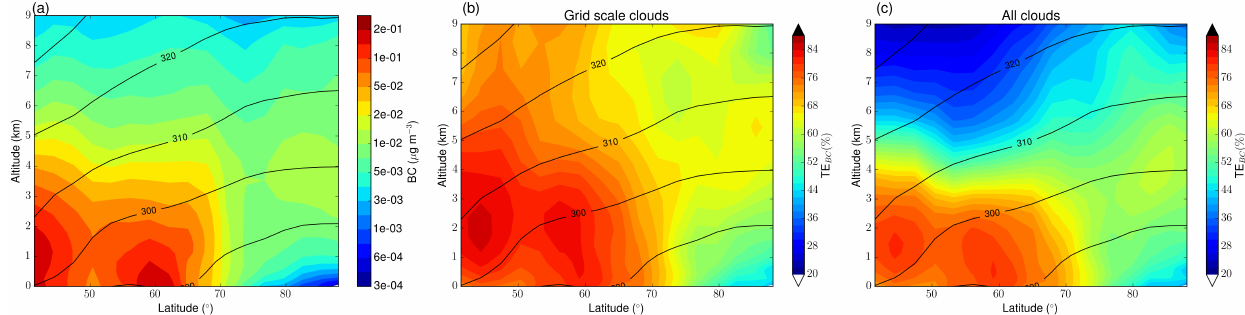
Figure 14. Latitude–altitude cross sections of (a) the BC mass concentrations, and the corresponding TE BC values due to (b) grid-scale clouds and (c) all clouds, averaged zonally and temporally over the ACCESS campaign period in the BASE run. On each panel, black solid lines represent the dry isentropes between 290 and